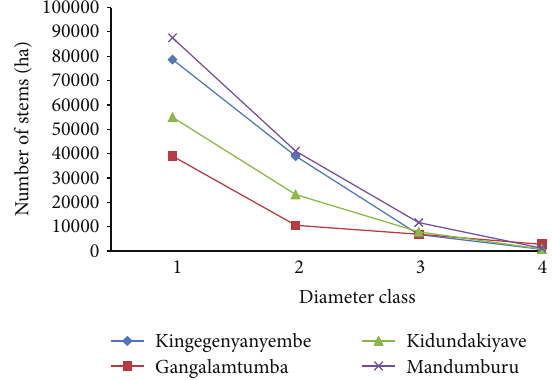
Figure 2: Distribution of tree diameter class in studied miombo